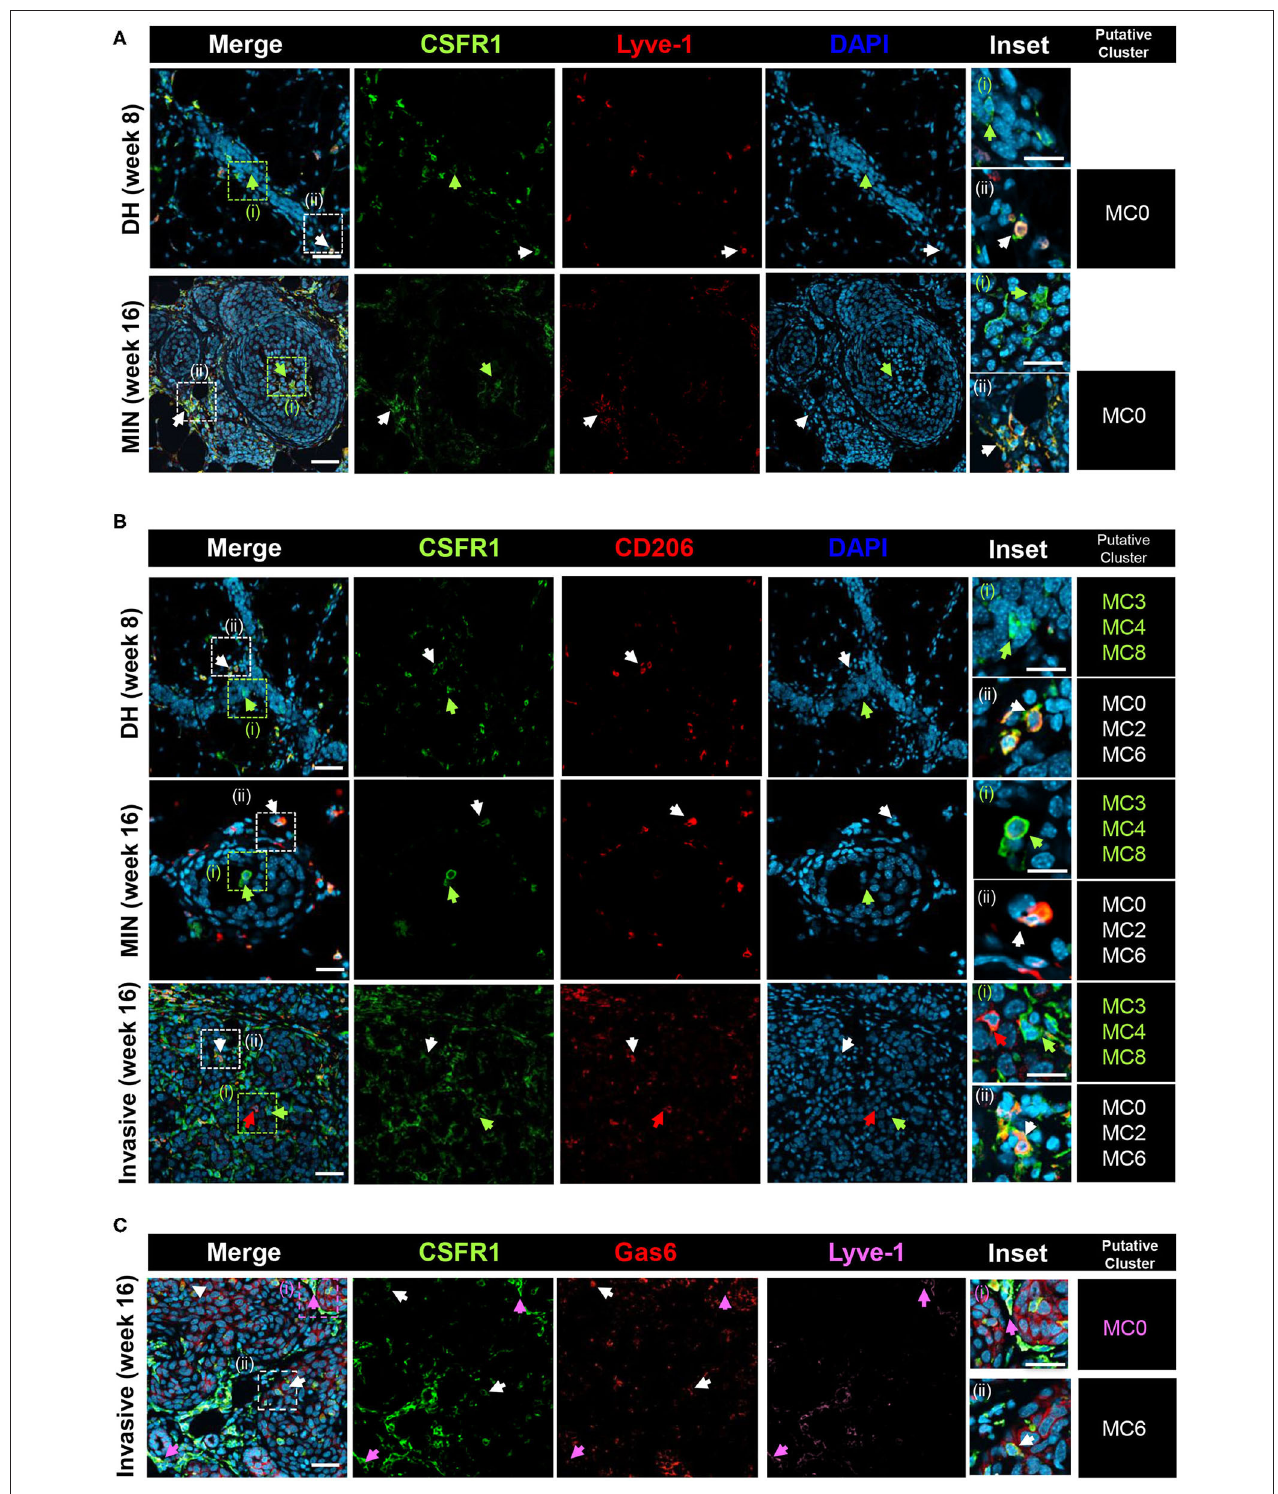
FIGURE 4 | Co-localization of putative macrophage populations. PN1a lesions showing ductal hyperplasia (DH) (week 8), MIN (week 16) or areas of invasion (16 week) were stained with various antibodies and DAPI and imaged by confocal microscopy. Putative myeloid cell clusters representative of the staining are listed (far right column) (A) CSFR1 (green) or Lyve-1 (red). White arrows: CSFR1 + Lyve-1 + (MC0); green arrows: CSFR1 + Lve-1 − . (B) CSFR1 (green) or CD206 (red). White arrows: CSFR1 + CD206 + (MC0, MC2, MC6); green arrows: CSFR1 + CD206 − (MC3, MC4, MC8). (C) CSFR1 (green), Gas6 (red) or Lyve-1 (purple). White arrows: CSFR1 + Gas6 + Lyve-1 − (MC6); purple arrows: CSFR1 + Gas6 + Lyve-1 + (MC0). Scale bars = 100 and 25 µ m for inset ( n = 3 per timepoint).